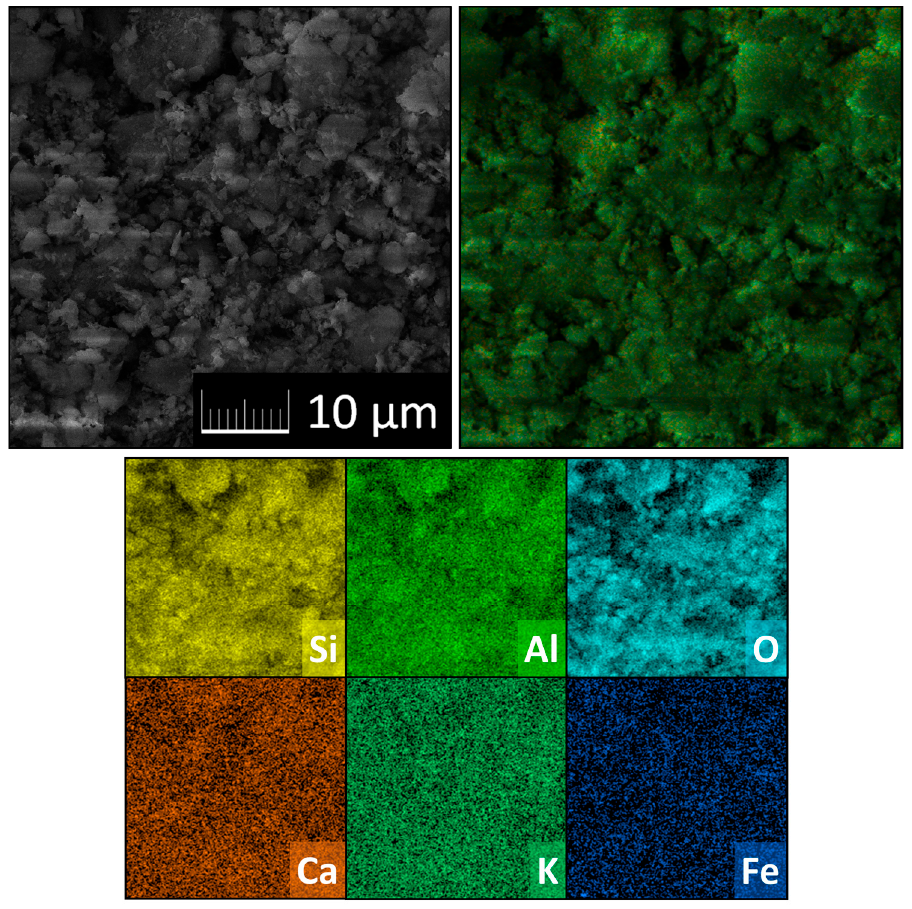
Figure 3. Elemental maps of zeolite, fraction 0.5–1 mm. The particle size distribution curves of zeolite and sand mixtures measured by the standard sieve analysis are shown in Figure 4.